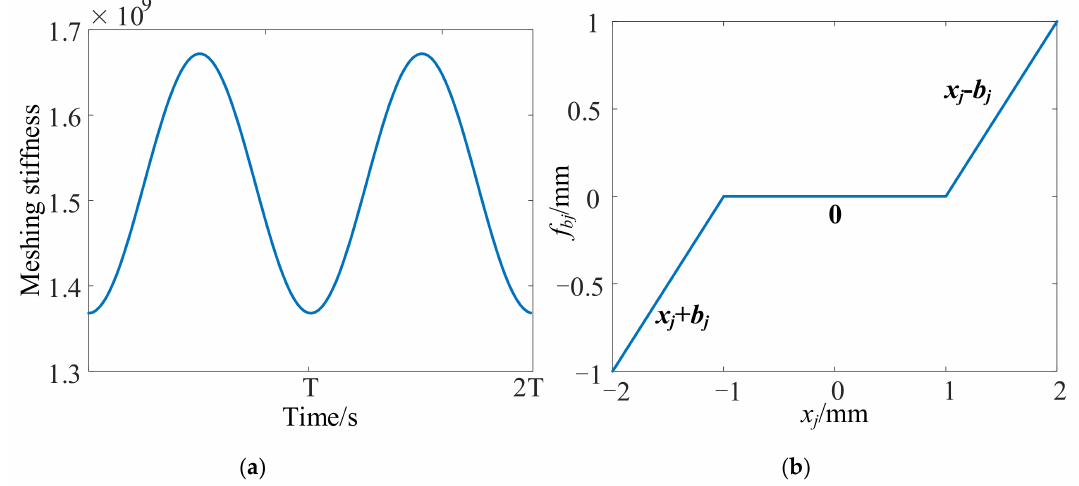
Figure 4. Schematic diagram of meshing stiffness and gear backlash. ( a ) Schematic diagram of meshing stiffness ( b ) Sche- matic diagram of gear backlash.